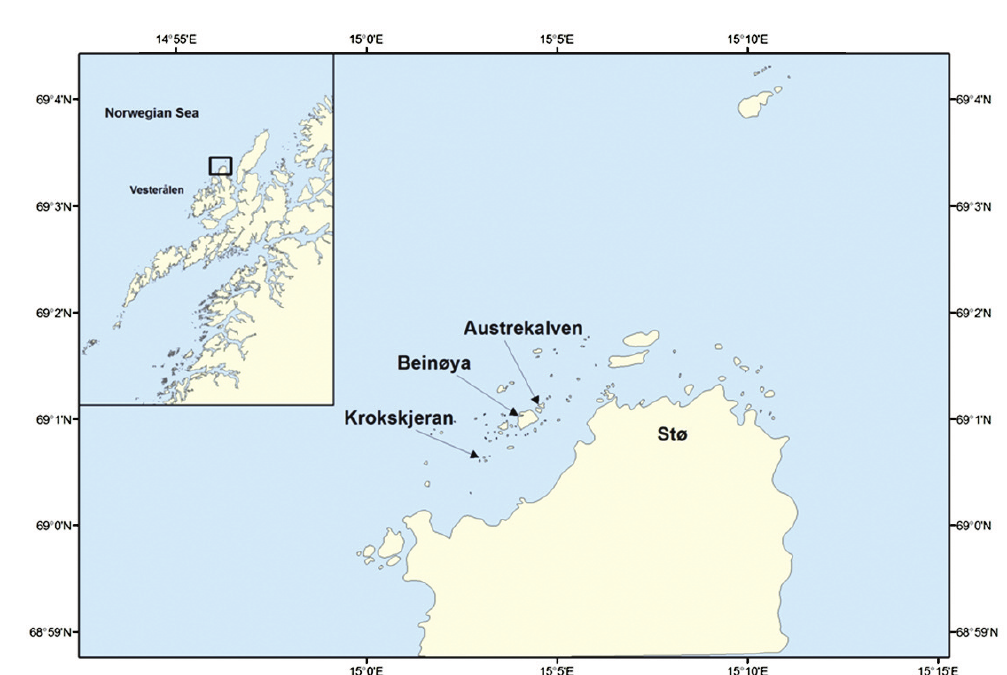
Fig. 1 . The study area west of Stø in Vesterålen, North